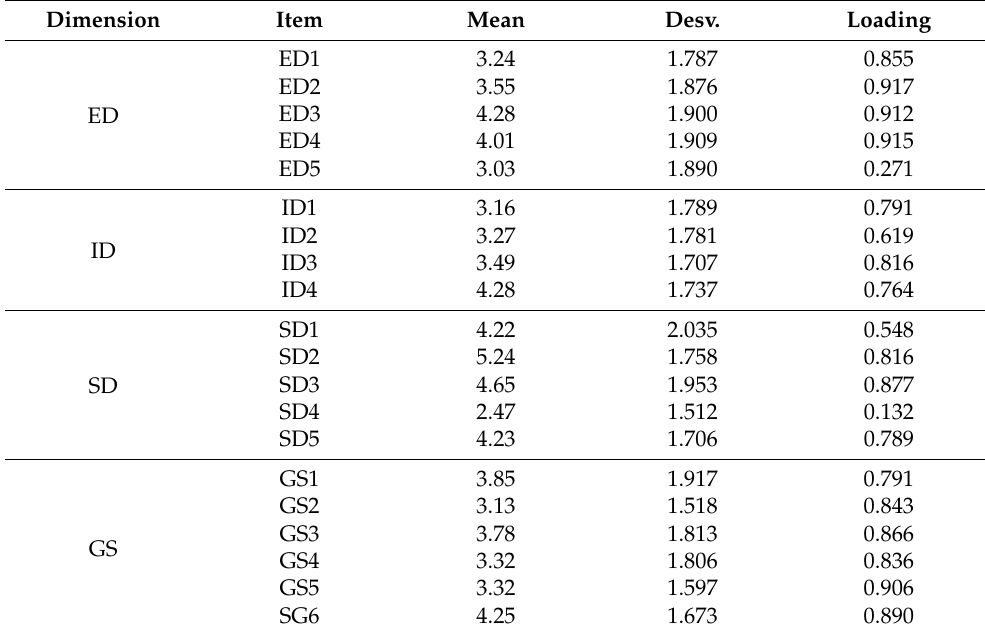
Table 3. Descriptive statistics and indicator